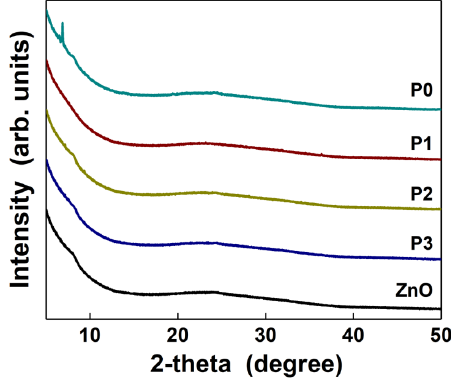
Figure 3. XRD patterns of the MAPLE-deposited thin films.